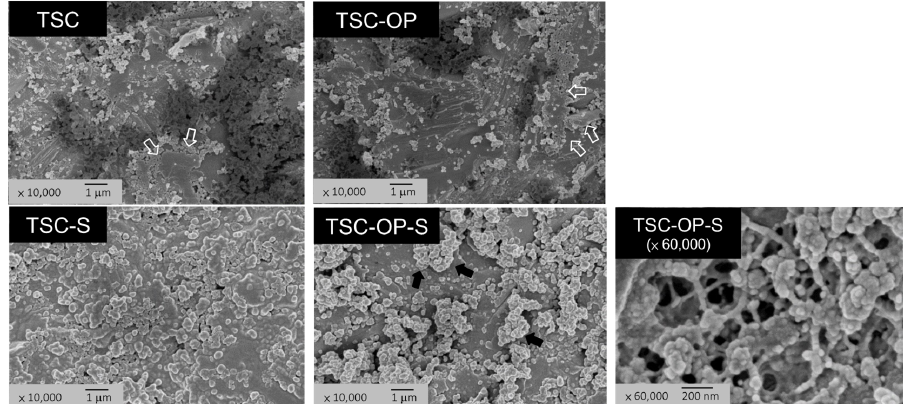
Figure 3. High-magnification images of the TSC-treated specimens (10,000 × ). TSC and TSC-OP exhibited retained Rocatec soft particles and fused layers (hollow arrows). TSC-OP-S showed a homogeneous coating, while TSC-OP-S showed particle agglomerates (solid arrows) on the coated layer. Under 60,000 × magnification, a network structure with linkages of SiO 2 particles was found in TSC-OP-S.